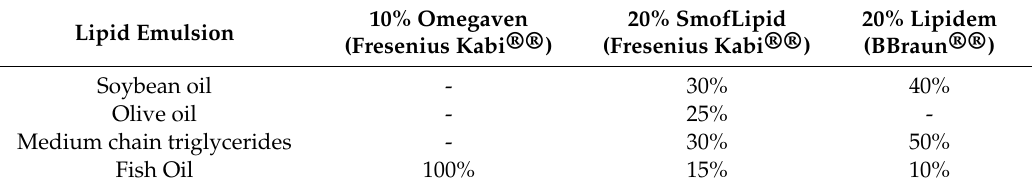
Table 1. The characteristics of lipid emulsions containing fish